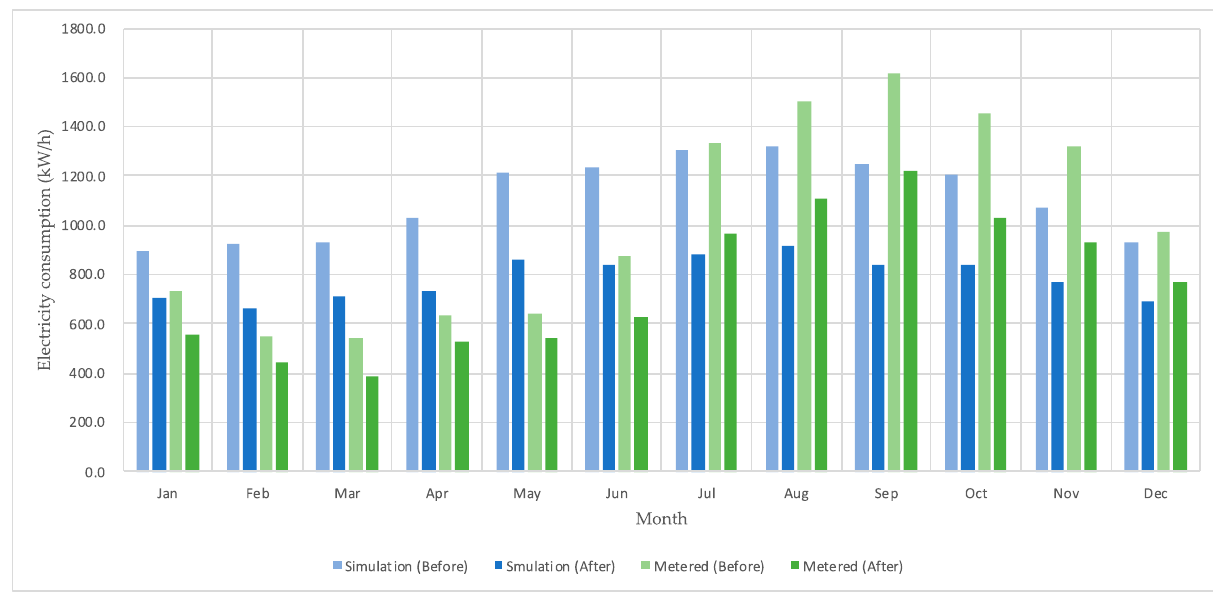
Figure 12. Comparing the monthly electricity consumption between simulation and metered.